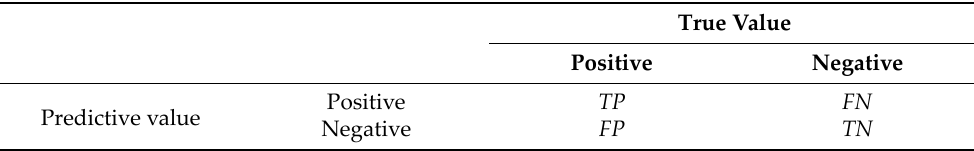
Table 1. The metrics used for evaluating performance of classifiers.